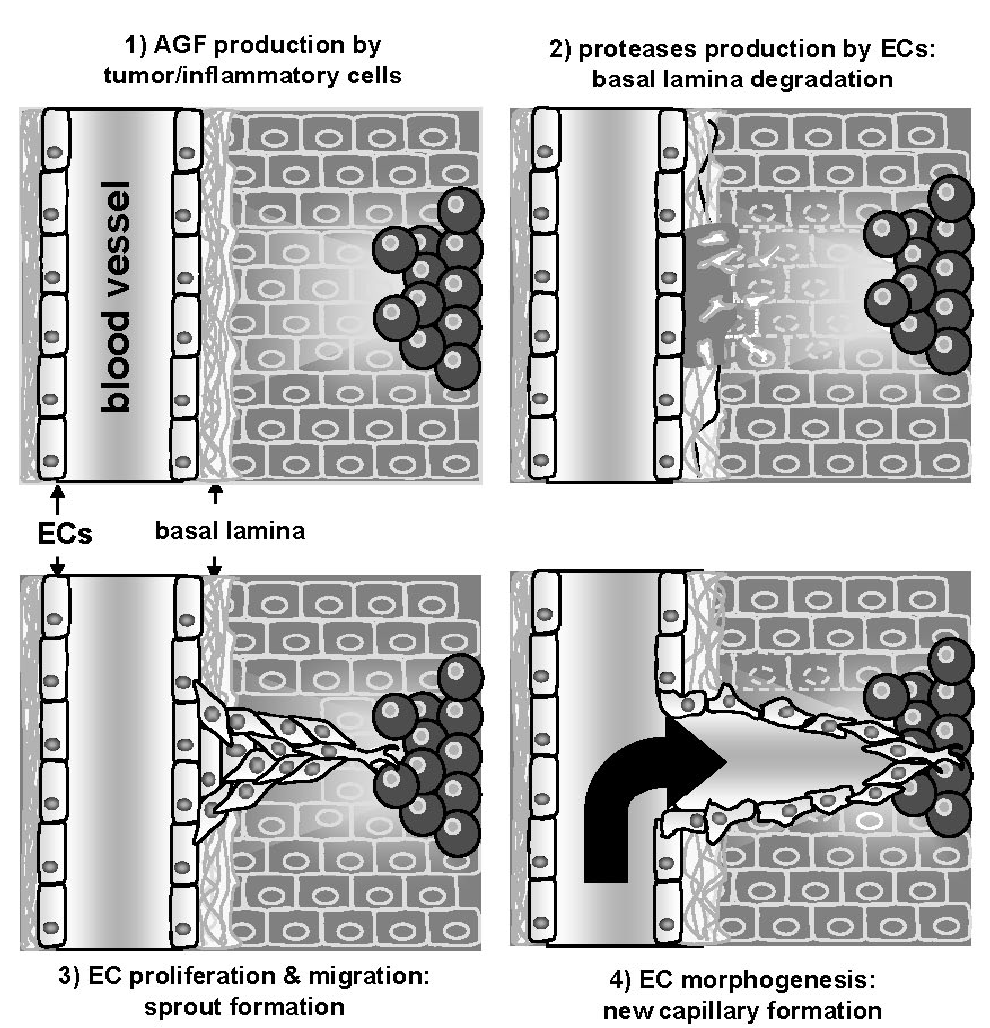
Figure 1. Schematic representation of the neovascularization process. Adapted from